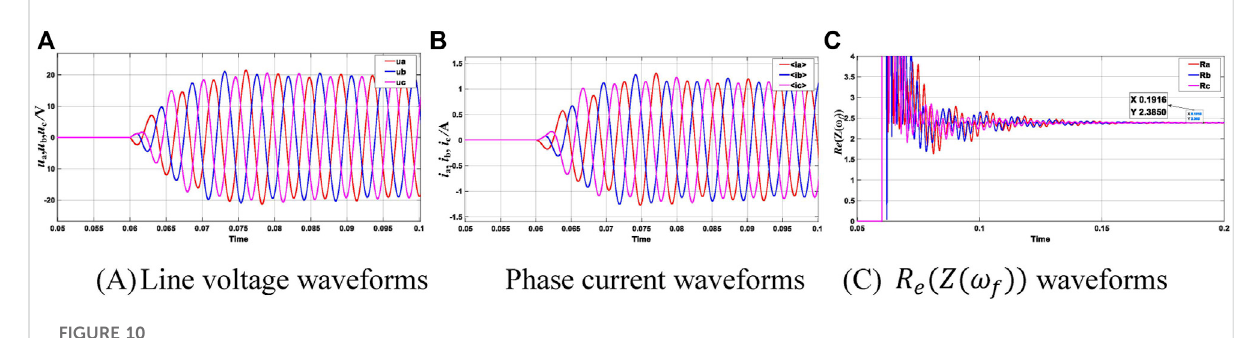
FIGURE 10 Permanent three-phase short circuit fault at end of Line1.